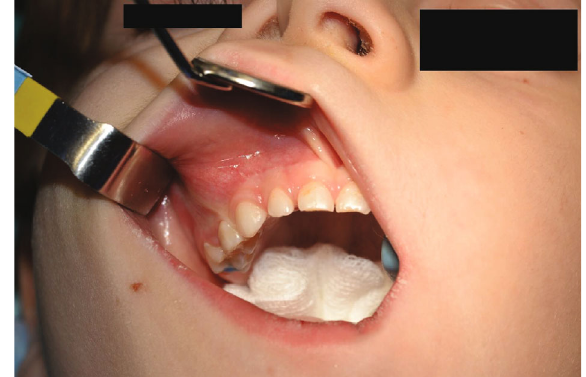
Figure 1: Intraoral view on the operative